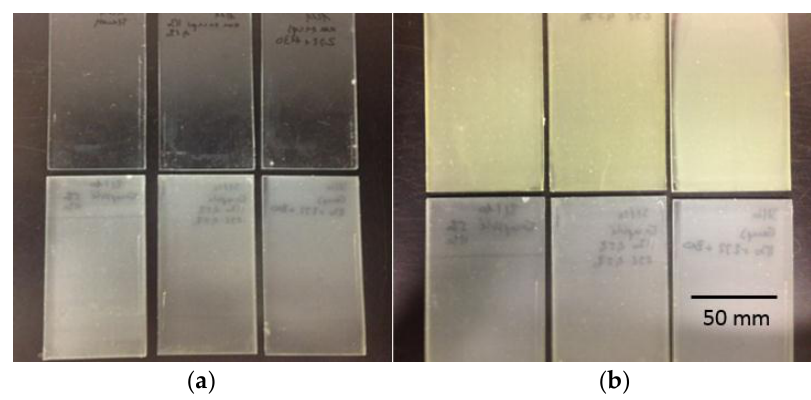
Figure 13. Photos before ( a ) and after ( b ) weathering of the non-encapsulated formulations on glass support of 68 mm × 144 mm × 4 mm (top) and the encapsulated ones (bottom).